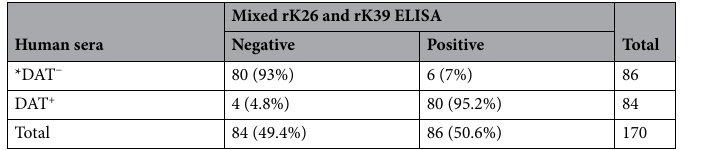
Table 1. Comparison between DAT and mixed rK39 and rK26 on human serum samples. *DAT − contain healthy individuals (n = 66) and other infectious diseases (n = 20) as control group.